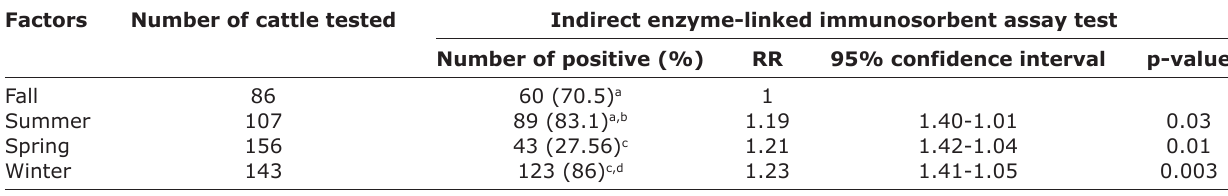
Table-2: Seasonal factors associated with the prevalence of bovine respiratory syncytial virus. Factors Number of cattle